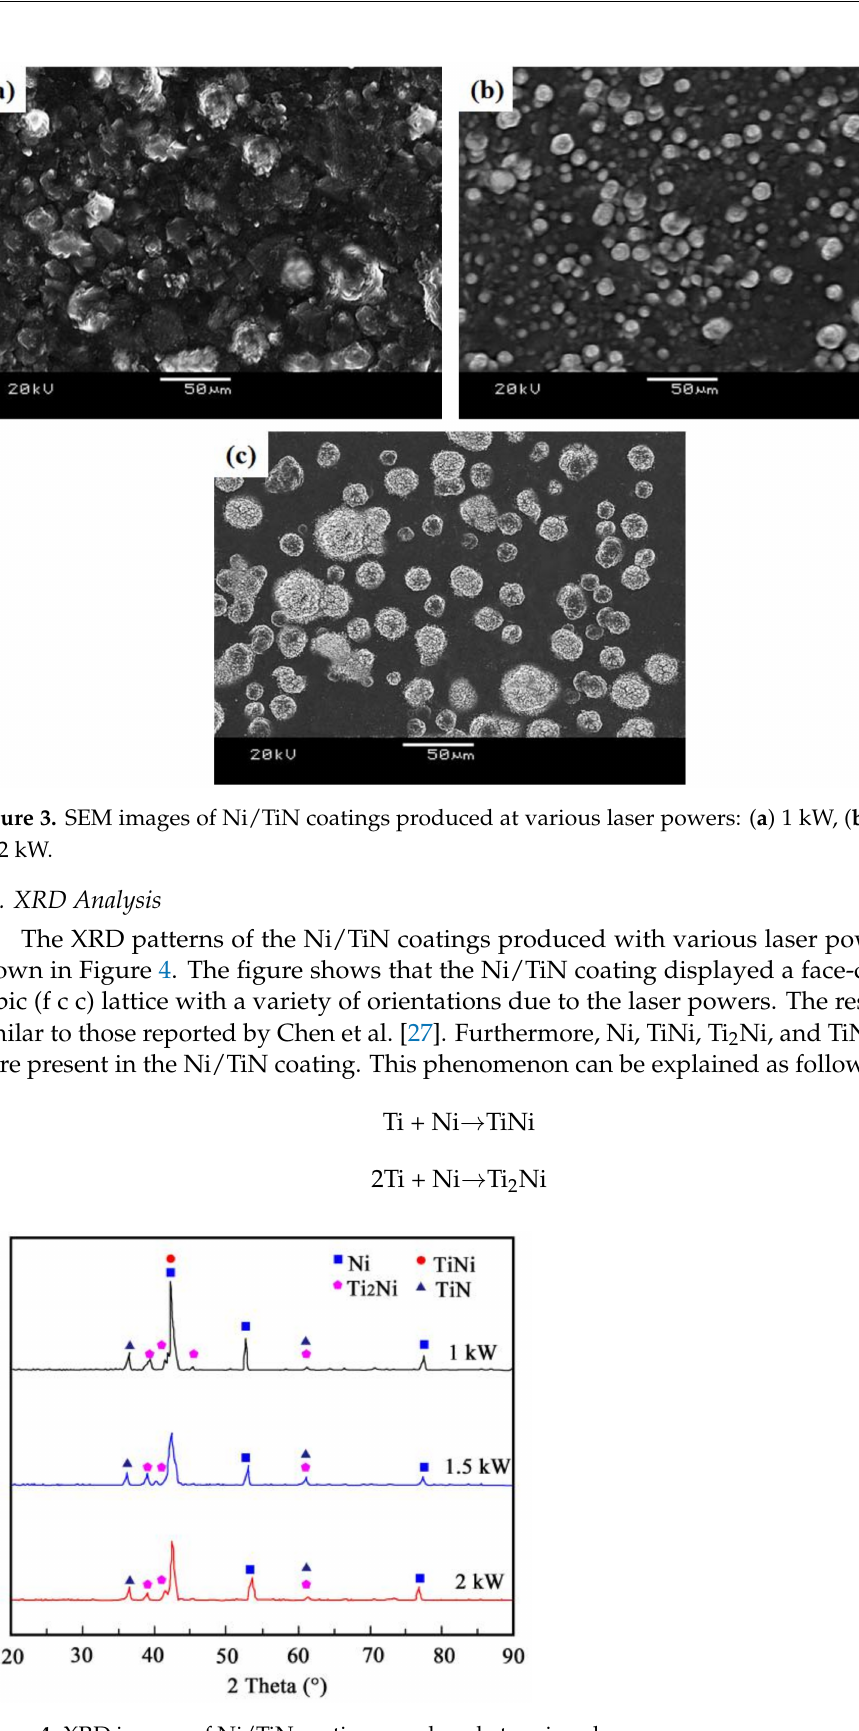
Figure 4. XRD images of Ni/TiN coatings produced at various laser